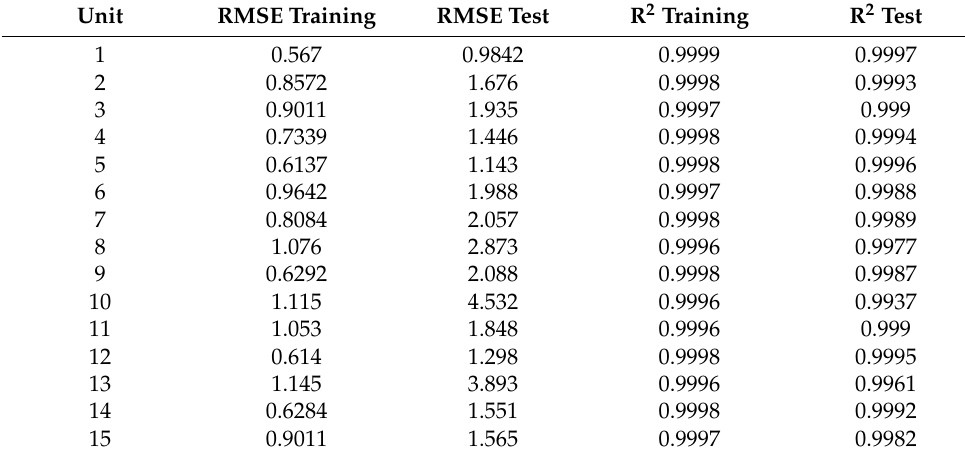
Table 5. RMSE and R 2 per unit for DS03.